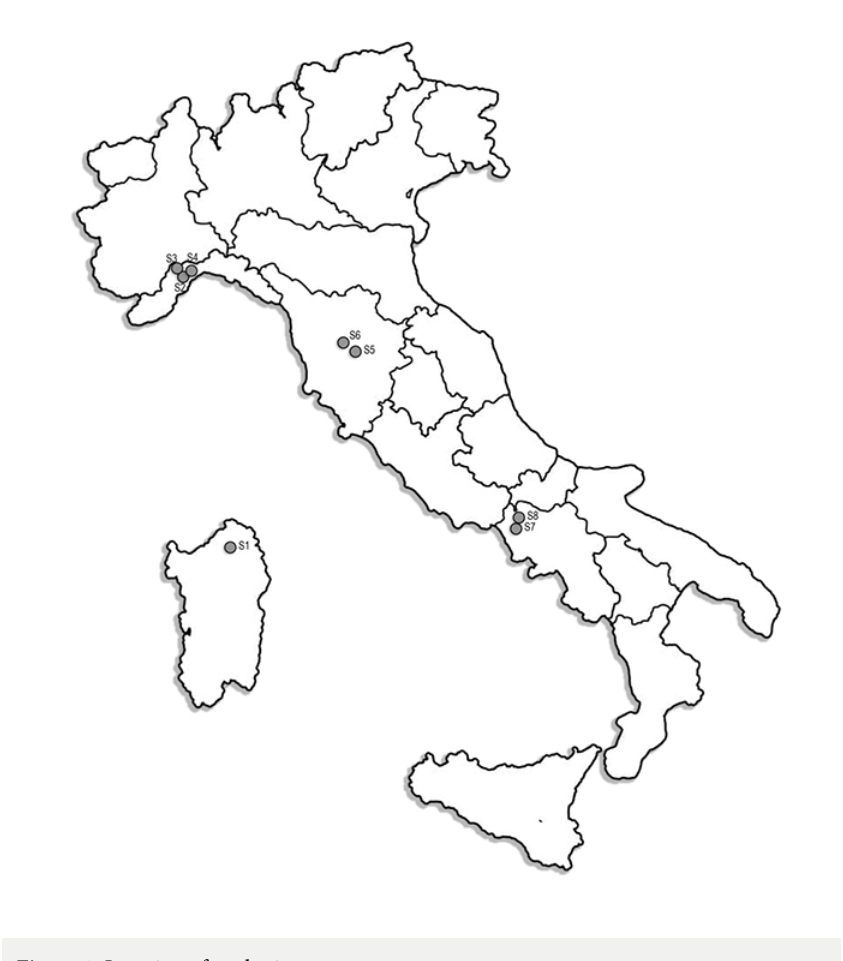
Figure 1 Location of study